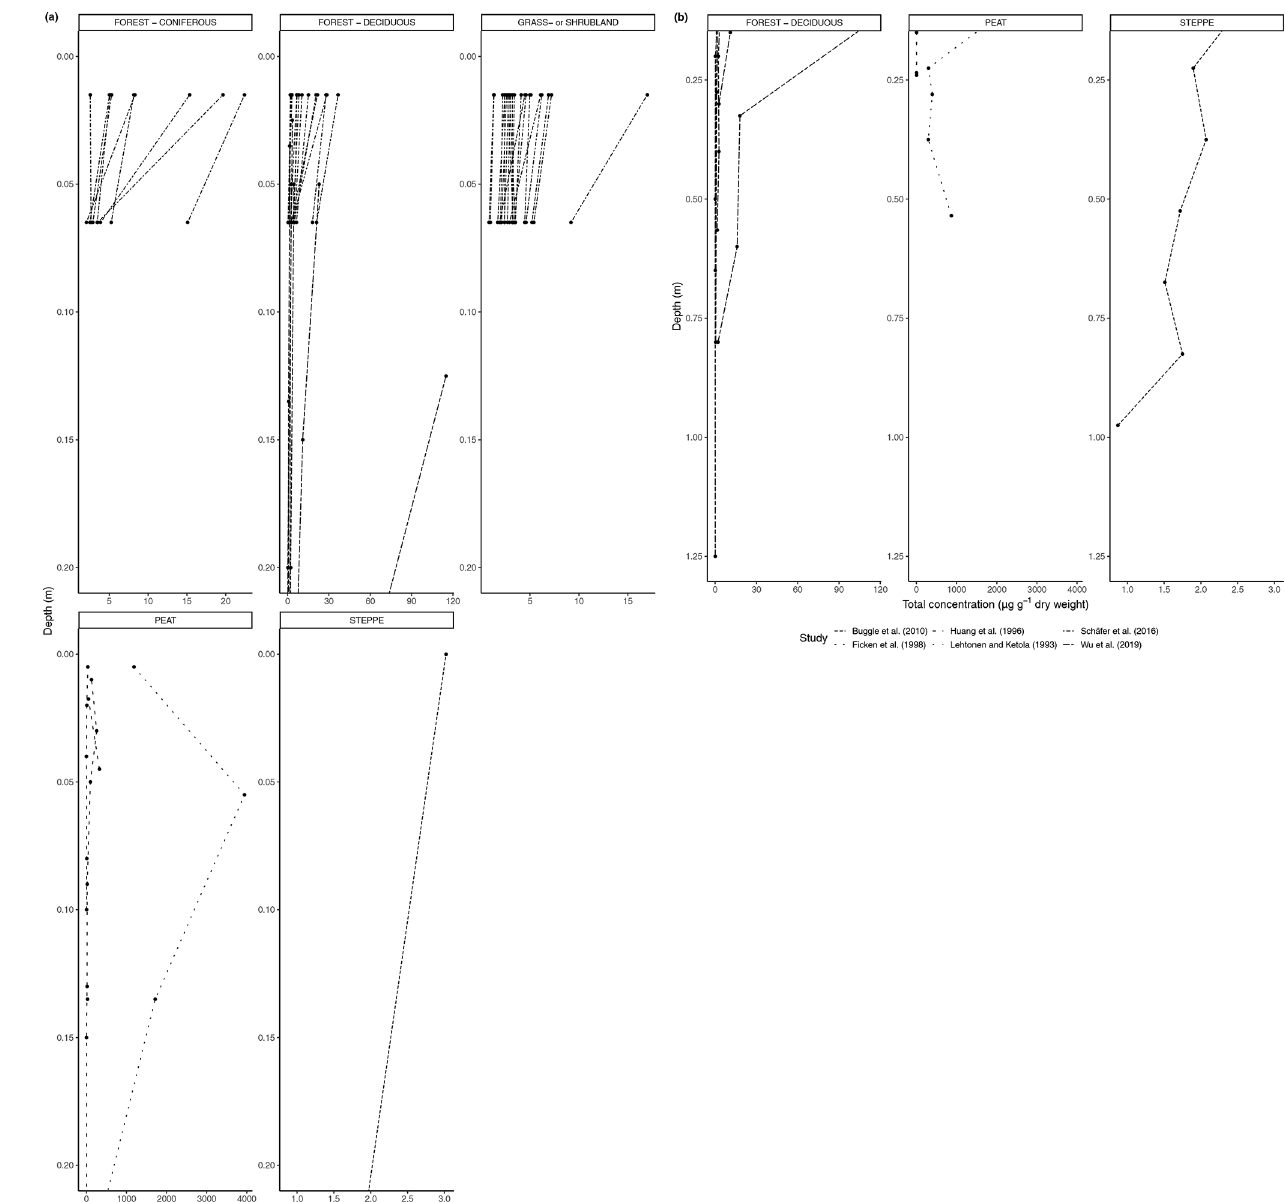
Figure 5. (a) Total concentration (µg/g dry weight) of n -alkanes in soil from 0 to 20cm. (b) Total concentration (µg/g dry weight) of n -alkanes in soil below